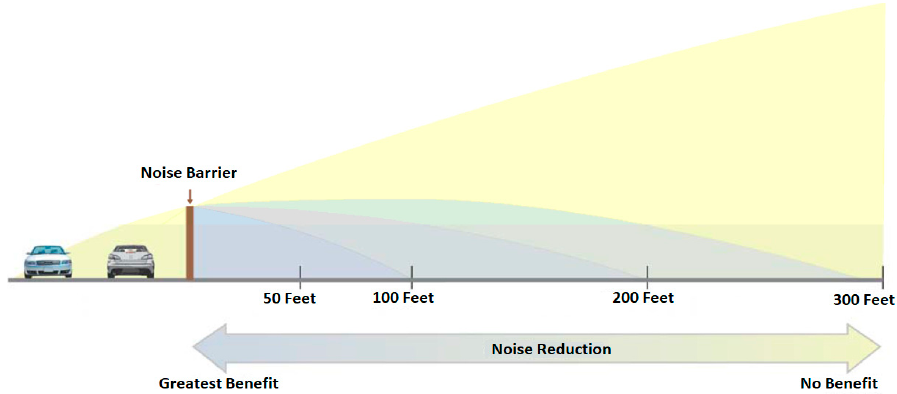
Figure 1. Noise barrier effectiveness